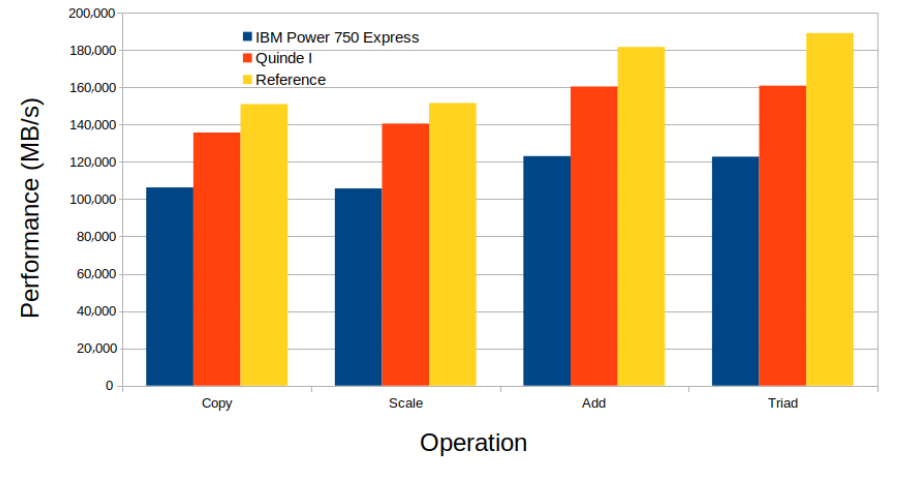
Figure 9. Histogram analysis of ‘Quinde I Vs IBM Power 750 and Power S822LC processor for